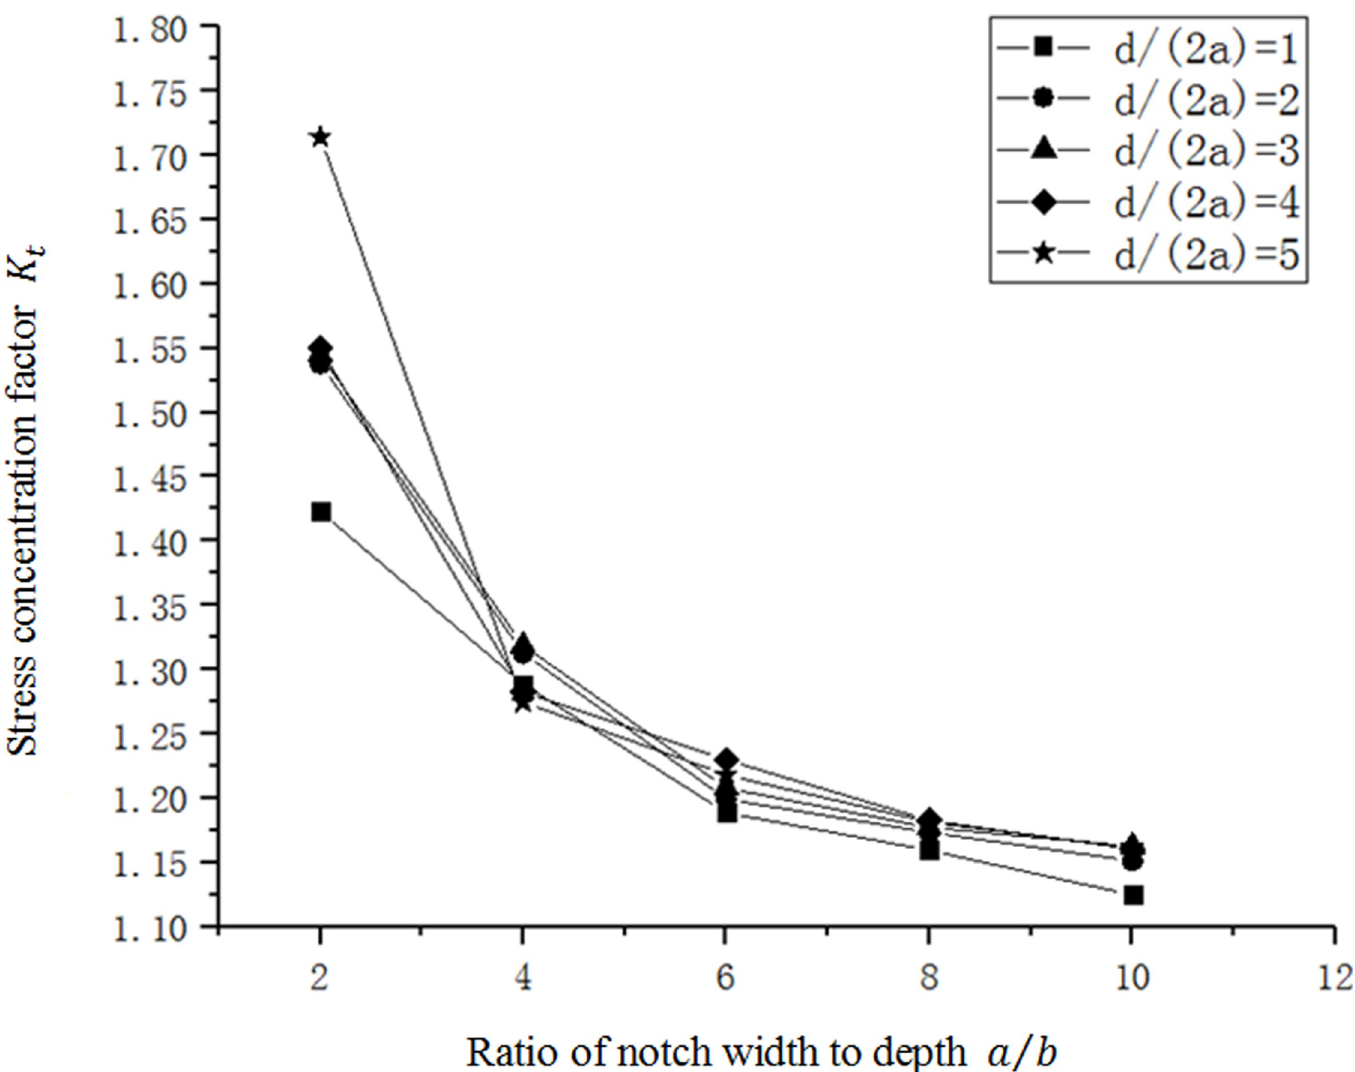
Fig 11. Relation between a / b and K